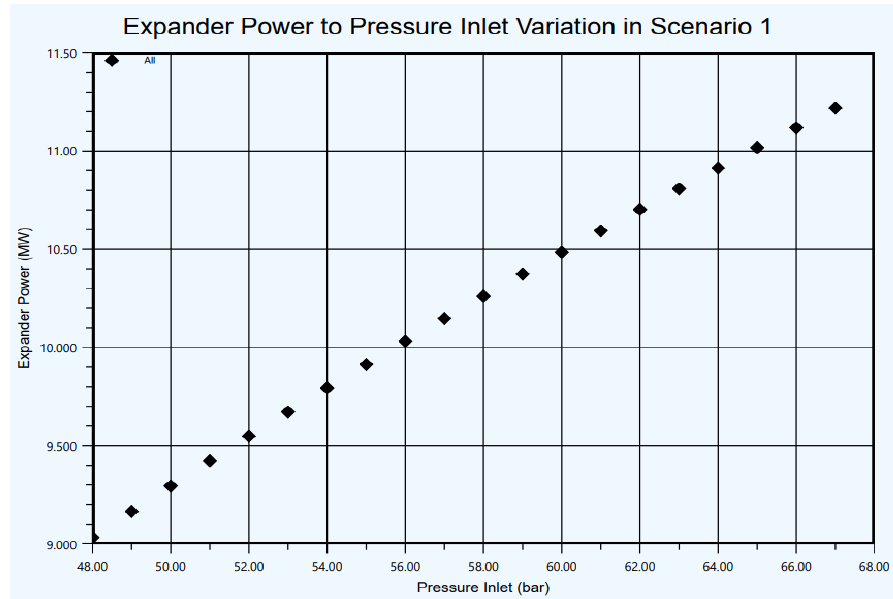
Figure 8. Expander power to gas feed pressure curve for scenario 1.